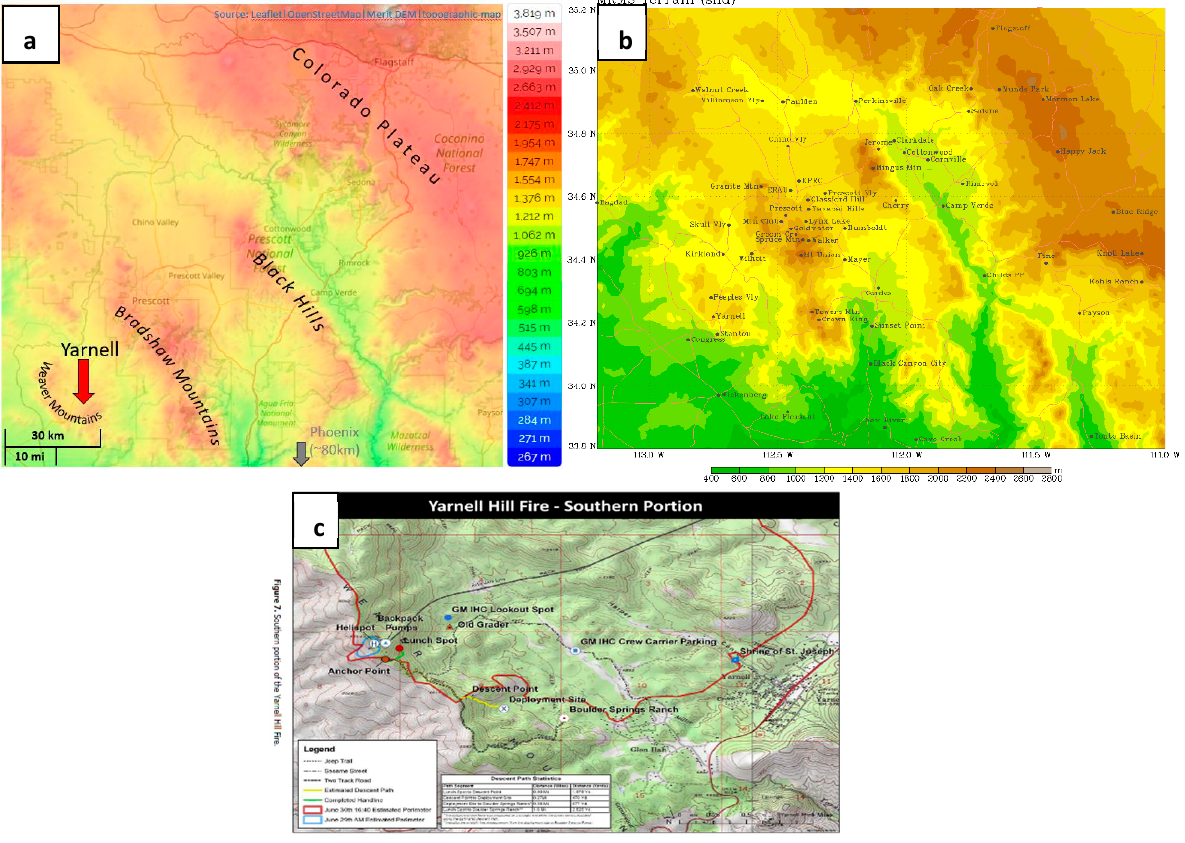
Figure 1. ( a ) Map of Central Arizona’s broader scale topography [8], ( b ) localized terrain centered on Yavapai County, and ( c ) key locations and terrain immediately surrounding the Yarnell Hill Fire [5]. Note the key yellow trail marker and the first x location where the YHFT occurs.